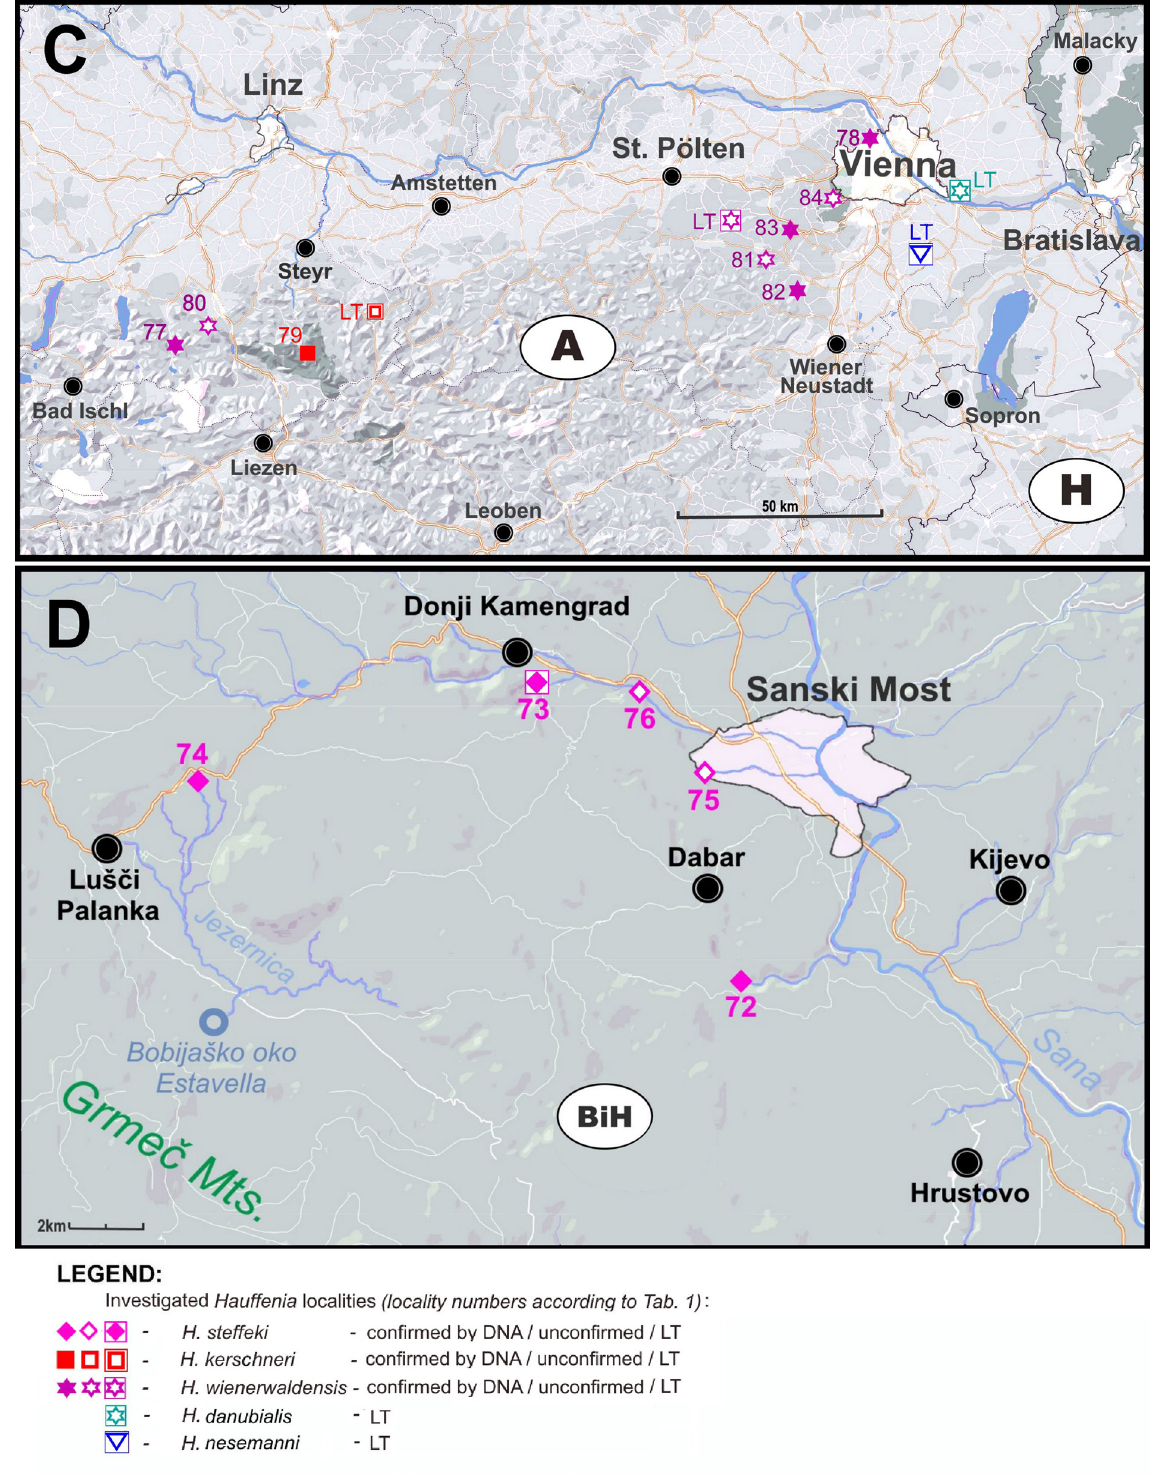
Fig. 3. Localities in Austria (C) and Bosnia and Herzegovina (D). Abbreviation: LT = type